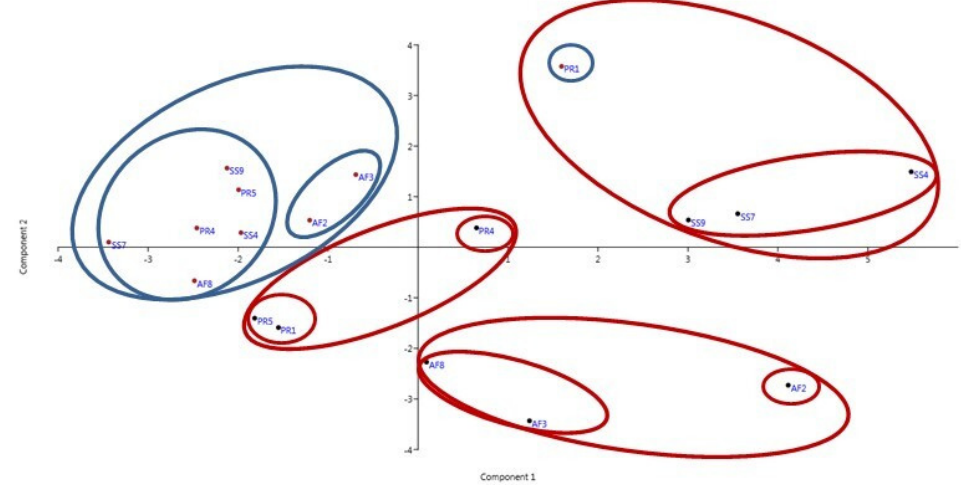
Figure 5. Clustering of the accessions on the score plot for the main two principal components. In the graph, black points refer to clary sage accessions cultivated in the first year while red points refer to accessions cultivated in the second year.